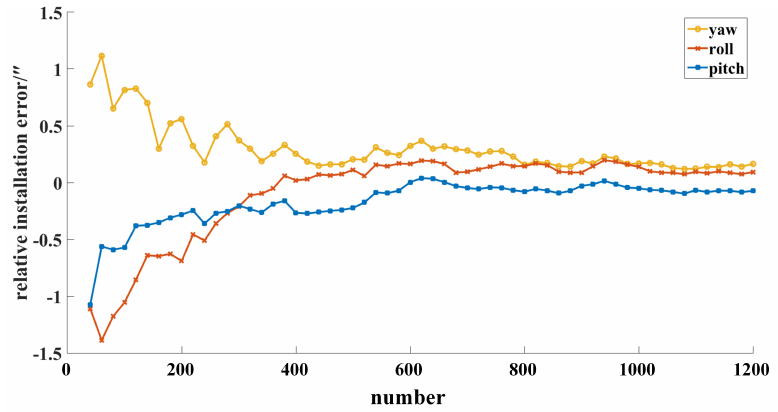
Figure 7. The relative installation error with different numbers of measurement